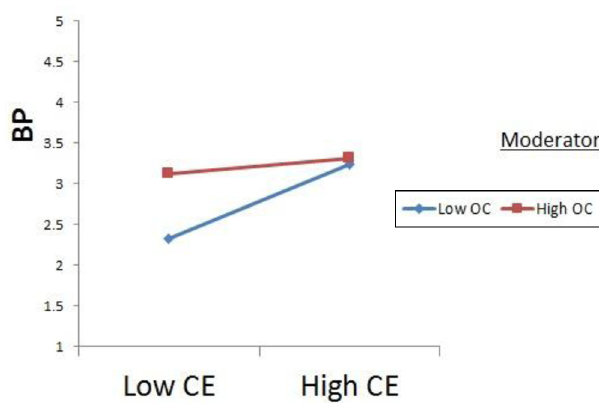
Figure 2. Interaction effect of CE and OC on